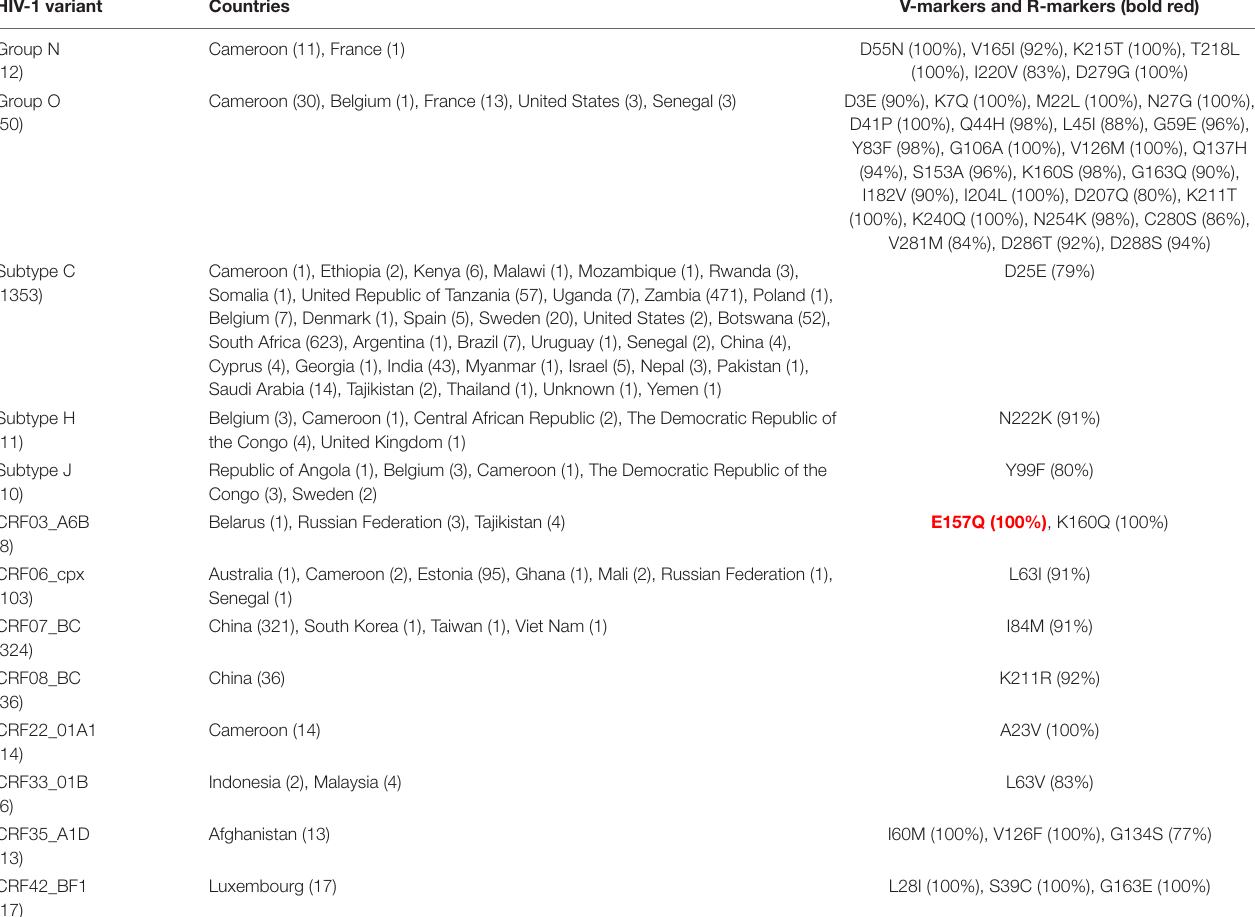
TABLE 4 | Single V-markers and R-markers in integrase found across HIV-1 variants with > 5 LANL sequences. HIV-1 variant V-markers and R-markers (bold